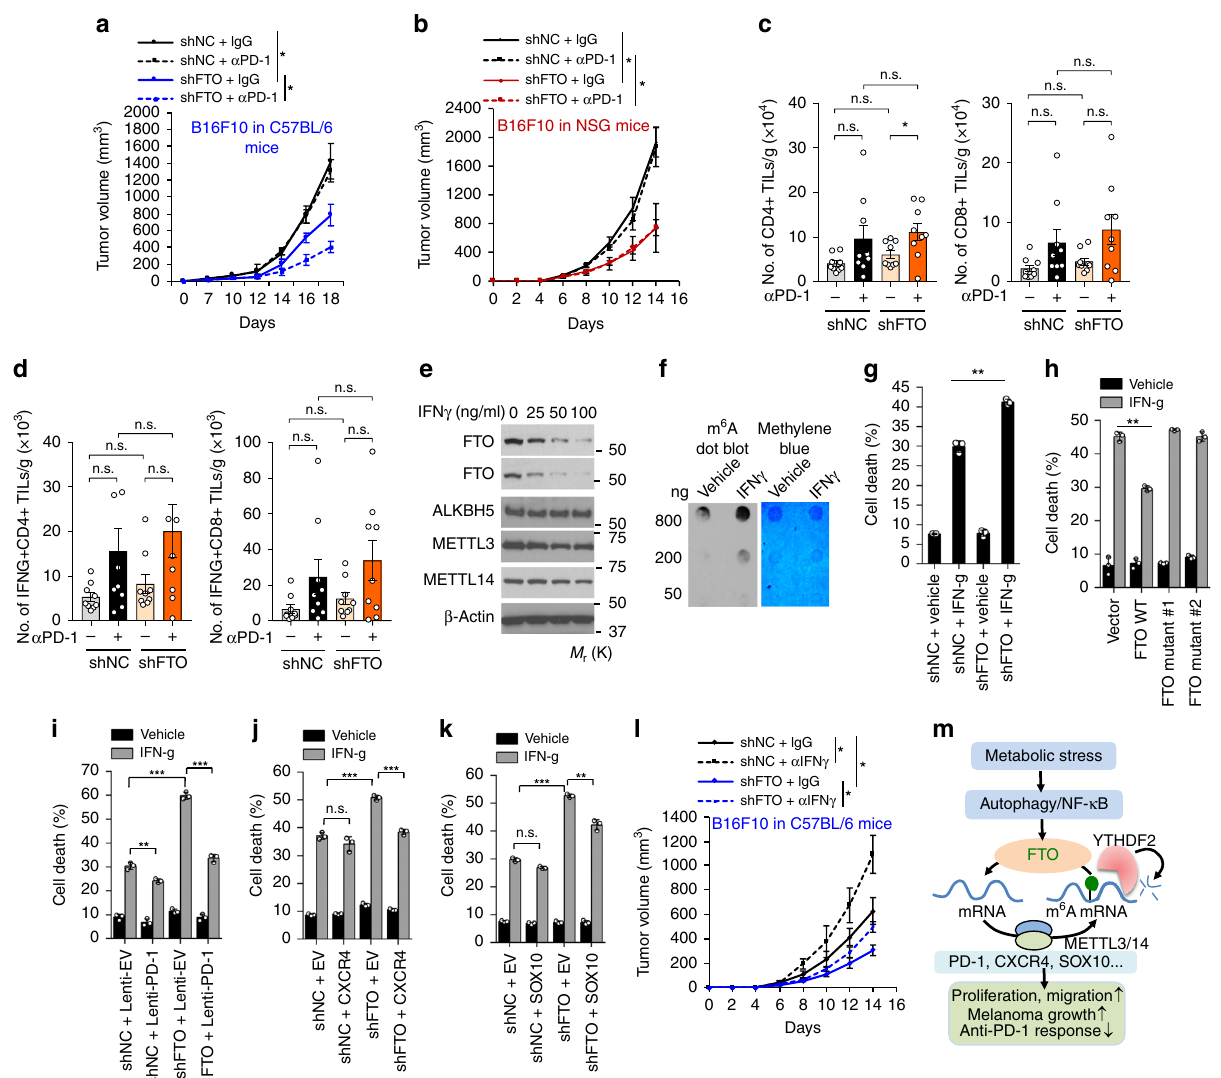
Fig. 8 Role of FTO in melanoma cell response to anti-PD-1 antibody in vivo or to interferon gamma (IFN γ ) in vitro. a , b Tumor growth kinetics of control or FTO-knockdown B16F10 cells in C57BL/6 mice ( a ) and NSG mice ( b ) treated with anti-PD-1 or isotype control antibody ( n = 4 – 6). * P < 0.05. c , d Flow cytometric analysis of the number of CD4 + and CD8 + TILs ( c ) and IFN γ -producing TILs ( d ) per gram of tumor tissue ( n = 9). Mann – Whitney U- test. * P < 0.05. n.s., not signi fi cant. e Immunoblot analysis of FTO, ALKBH5, METTL3, METTL14, and GAPDH in Mel624 cells treated with or without IFN γ (100 ng/ ml) for 24 h. f m 6 A dot blot assays using total RNA of Mel624 cells treated with or without IFN γ (100 ng/ml) for 24 h. g Apoptosis assay in Mel624 cells with or without FTO knockdown and treatment with or without IFN γ (50 ng/ml) for 48 h. h Apoptosis assay in Mel624 cells overexpressing vector, FTO WT, mutant 1, or mutant 2, and treated with or without IFN γ (50 ng/ml) for 48 h ( n = 3). ** P < 0.01, Student ’ s t -test. i – k Apoptosis assay in Mel624 cells with or without FTO knockdown overexpressing vector or PD-1 ( i ), CXCR4 ( j ), or SOX10 ( k ) treated with or without IFN γ (50 ng/ml) for 48 h ( n = 3). * P < 0.05; ** P < 0.01; *** P < 0.001; Student ’ s t -test. l Tumor growth of control or FTO-knockdown B16F10 cells in C57BL/6 mice treated with the anti-IFN γ antibody or isotype control IgG ( n = 4 – 6). Data are shown as mean ± S.E. ( a – e , and l ), or mean ± S.D. ( g – k ) ( n ≥ 3). * P < 0.05; ** P < 0.01; *** P < 0.001; Student ’ s t -test. m Proposed model of the regulatory and functional role for FTO in melanoma pathogenesis and response to anti-PD-1 blockade